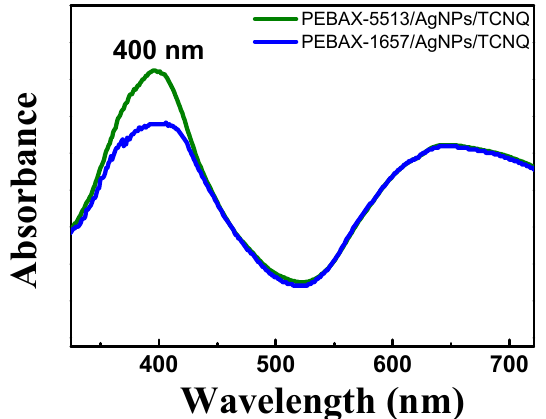
Figure 6. UV-visible absorption spectra of AgNPs in ( a ) PEBAX-1657/AgNPs, ( b ) PEBAX- 5513/AgNPs, ( c ) PEBAX-1657/AgNPs/TCNQ, and ( d ) PEBAX-5513/AgNPs/TCNQ composites. Figure6a,bshowstheasymmetricalpeakinPEBAX-1657/AgNPs and PEBAX-5513/AgNPs,